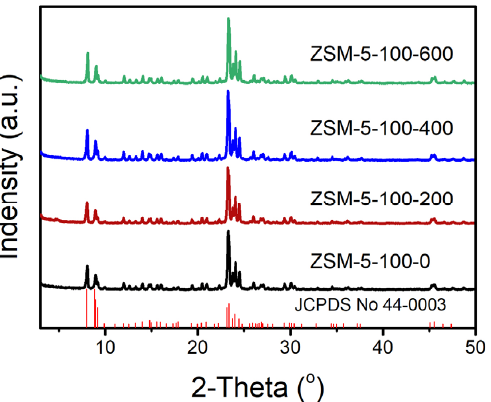
Figure 1. XRD patterns of ZSM-5 with Si/Al ratio of 100 synthesized with different amounts of toluene.